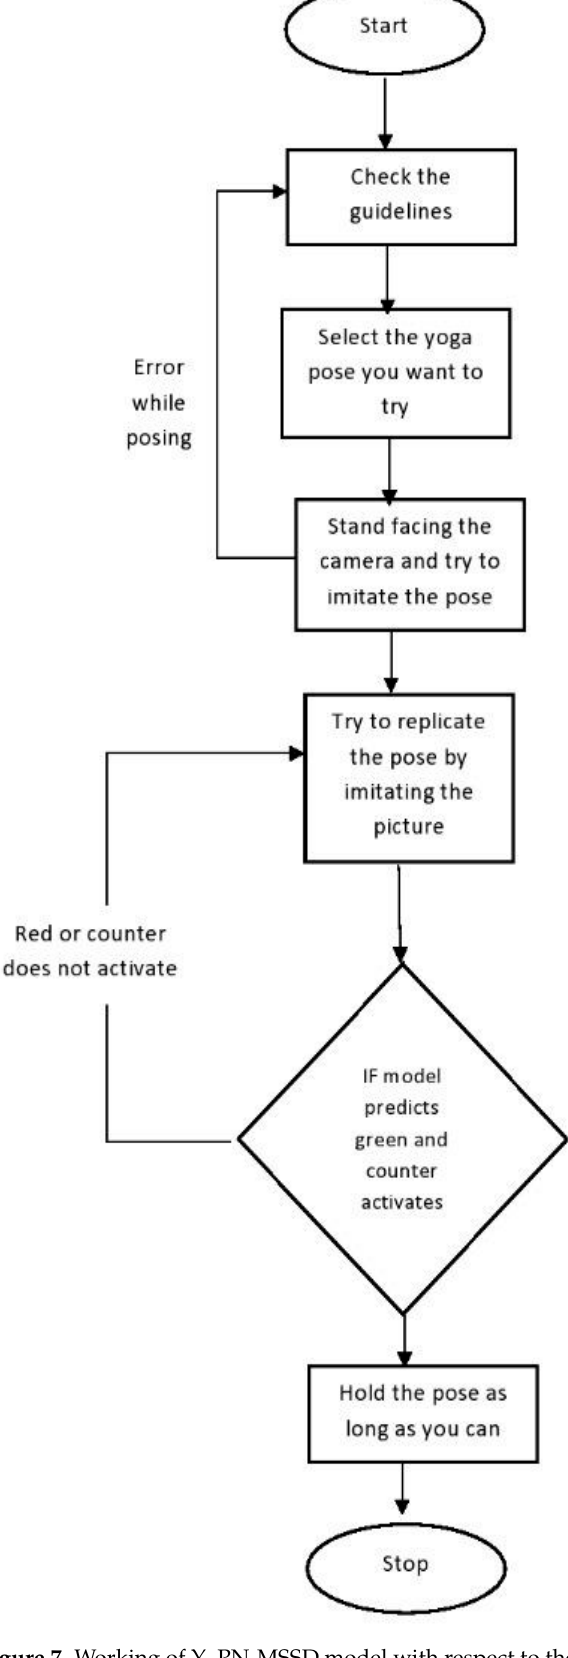
Figure 7. Working of Y_PN-MSSD model with respect to the user interface.